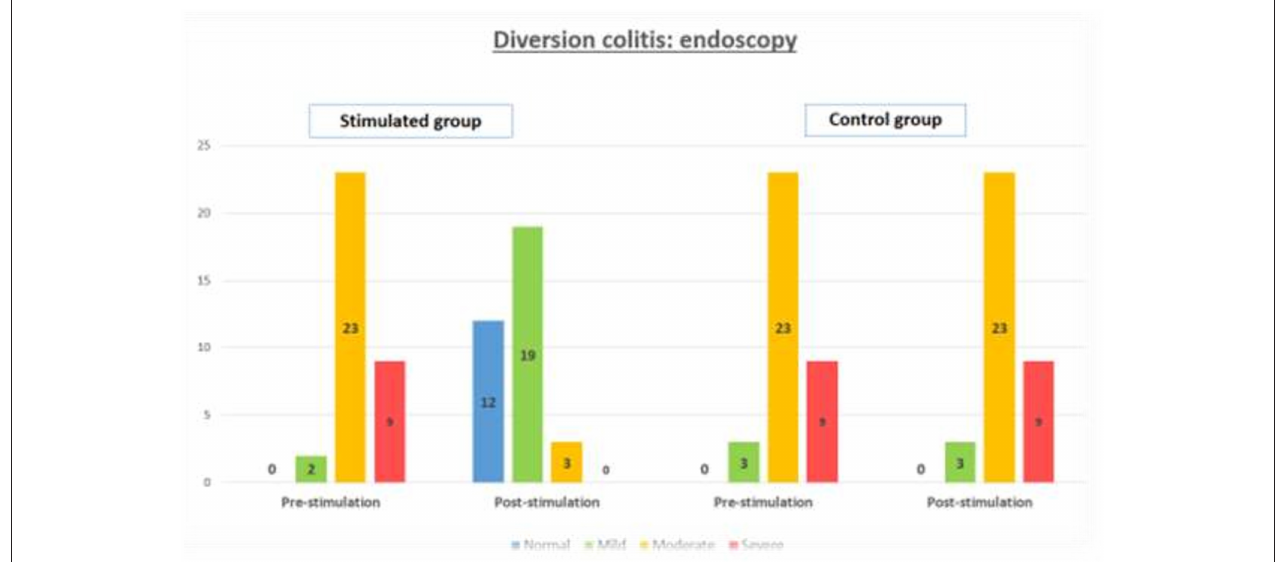
FIGURE 2 | Grade of macroscopic diversion colitis, measured by endoscopy, in the stimulated group and control group, in the pre-stimulation and post-stimulation phases.